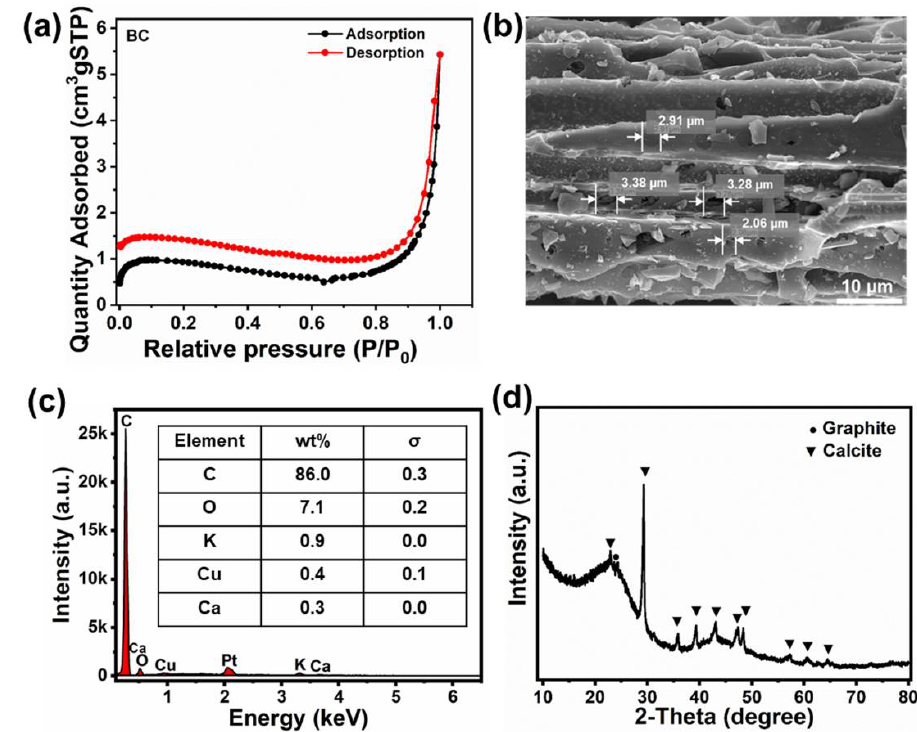
Figure 1. ( a ) N 2 adsorption-desorption isotherm of eucalyptus wood-derived biochar (BC), ( b ) SEM image and ( c ) corresponding EDX spectrum of the BC and ( d ) Powder XRD pattern of the BC. Note that, the observed Pt content found in ( c ) comes from the SEM coating.